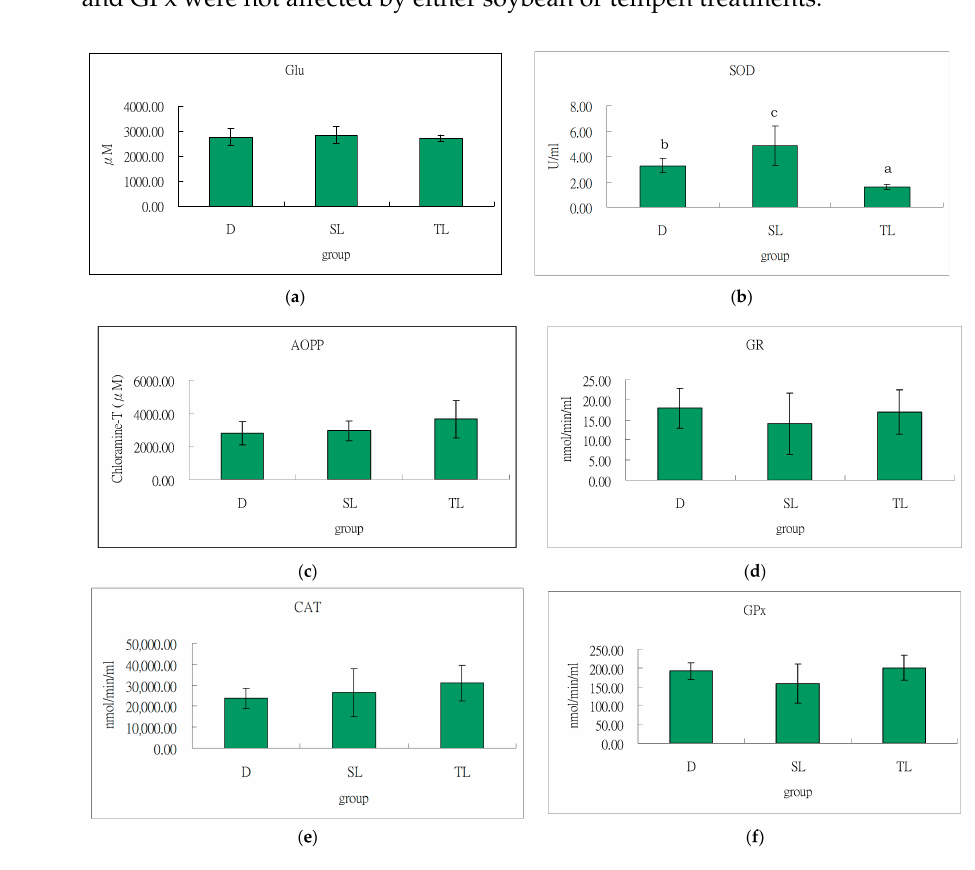
Figure 5. Effect of soybeans and tempeh on liver ( a ) glutathione (Glu), ( b ) superoxide Dismutase (SOD), ( c ) advanced oxidation protein products (AOPP), ( d ) glutathione reductase (GR), ( e ) catalase (CAT), ( f ) glutathione peroxidase (GPx) of SD rats. D: DMH, SL: DMH + 300 mg/kg BW soybeans, TL: DMH + 300 mg/kg BW tempeh. For D group, n = 10; SL, TL groups is n = 9; abc different letters indicate a significant difference as determined by ANOVA and Duncan’s